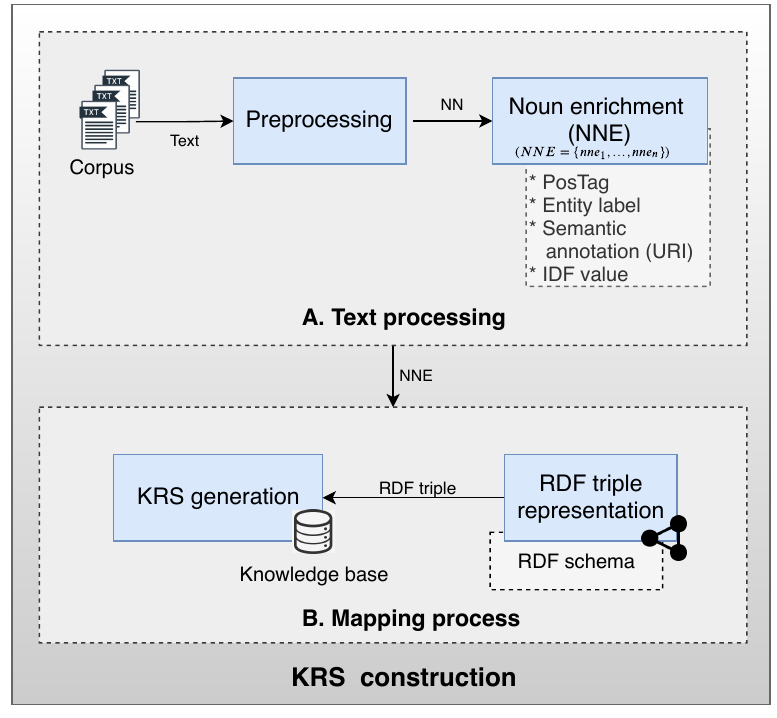
Figure 3. The KRS construction